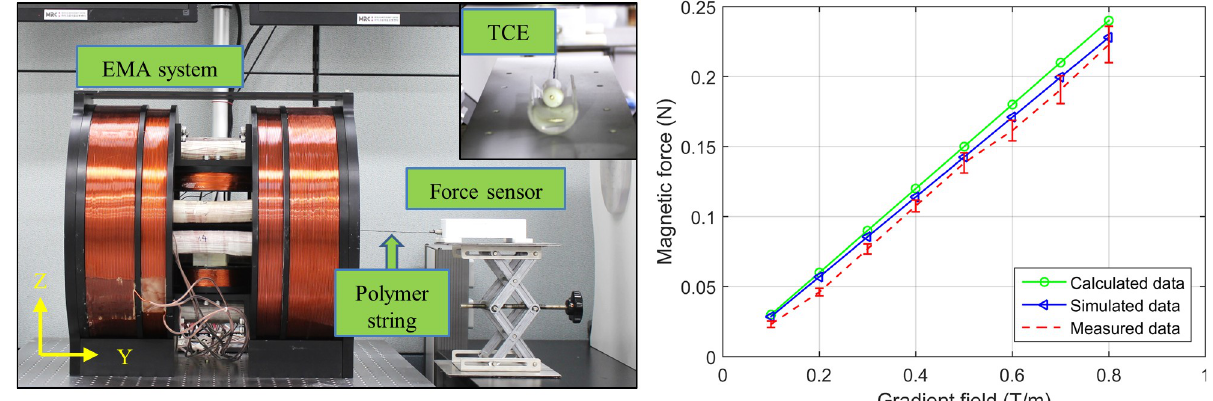
Fig 12. Measurements of magnetic force exerted on the TCE. (A) Experimental setup. (B) Electromagnetic force exerting on the TCE by the EMA system at various levels of the gradient